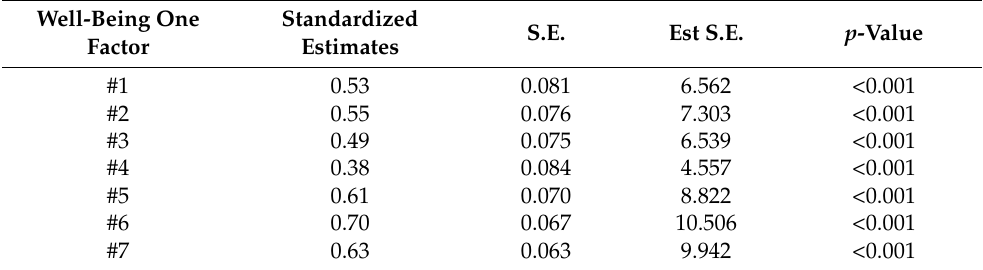
Table 4. Standardized estimates, one-factor model and standardized